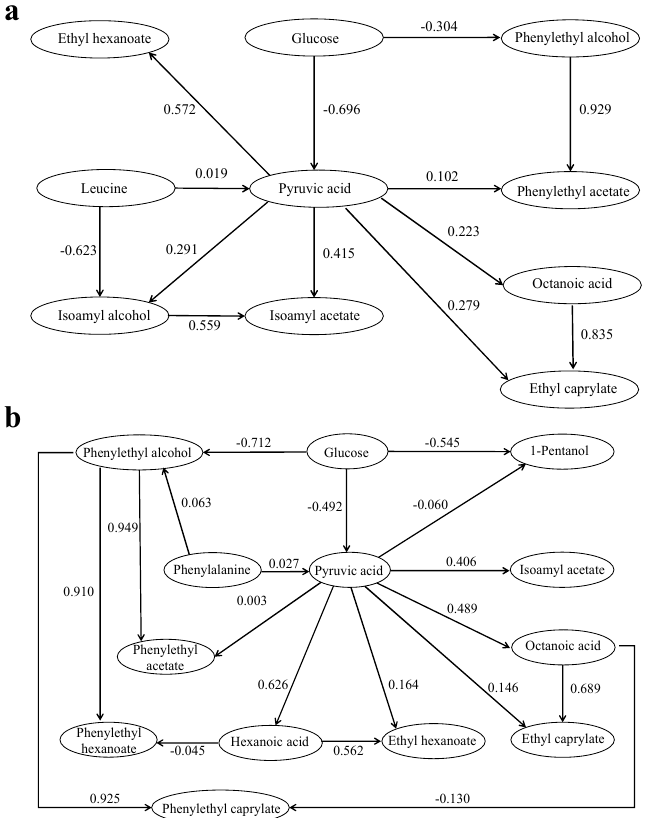
Figure 4. Path analysis on key compounds in simulated juice systems with the addition of amino acids during fermentation. ( a ) Leu-added; ( b )